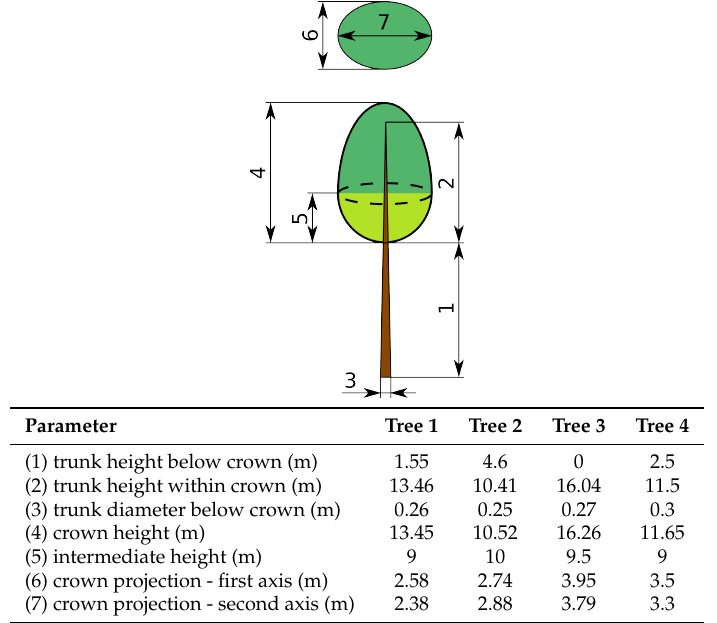
Table A1. Basic tree parameters used to construct spruce trees in DART using predefined tree shapes. The figure on the top illustrates the individual tree parameters (adapted from DART manual